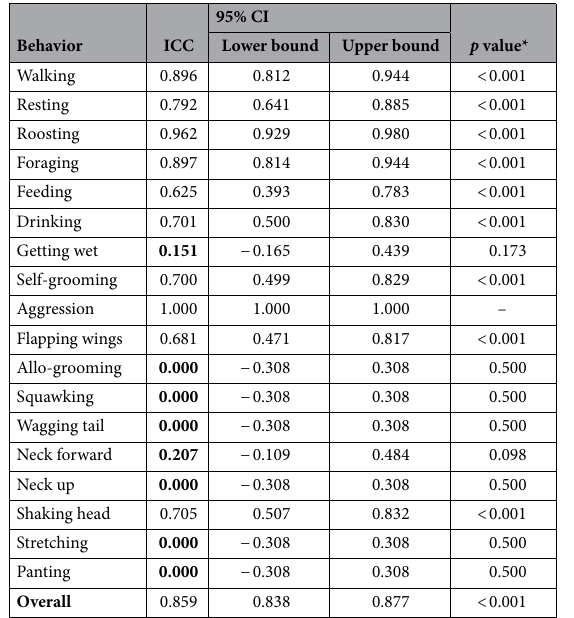
Table 2. Interobserver reliability. Intraclass correlation coefficients (ICCs) of the behavioral variables assessed by two observers. Each ICC is followed by its 95% confidence interval (CI) and by the p value of the F test. Poor or fair interobserver reliability (ICC < 0.60) is shown in bold. * F test for ICC. –Not computed as there was perfect agreement.